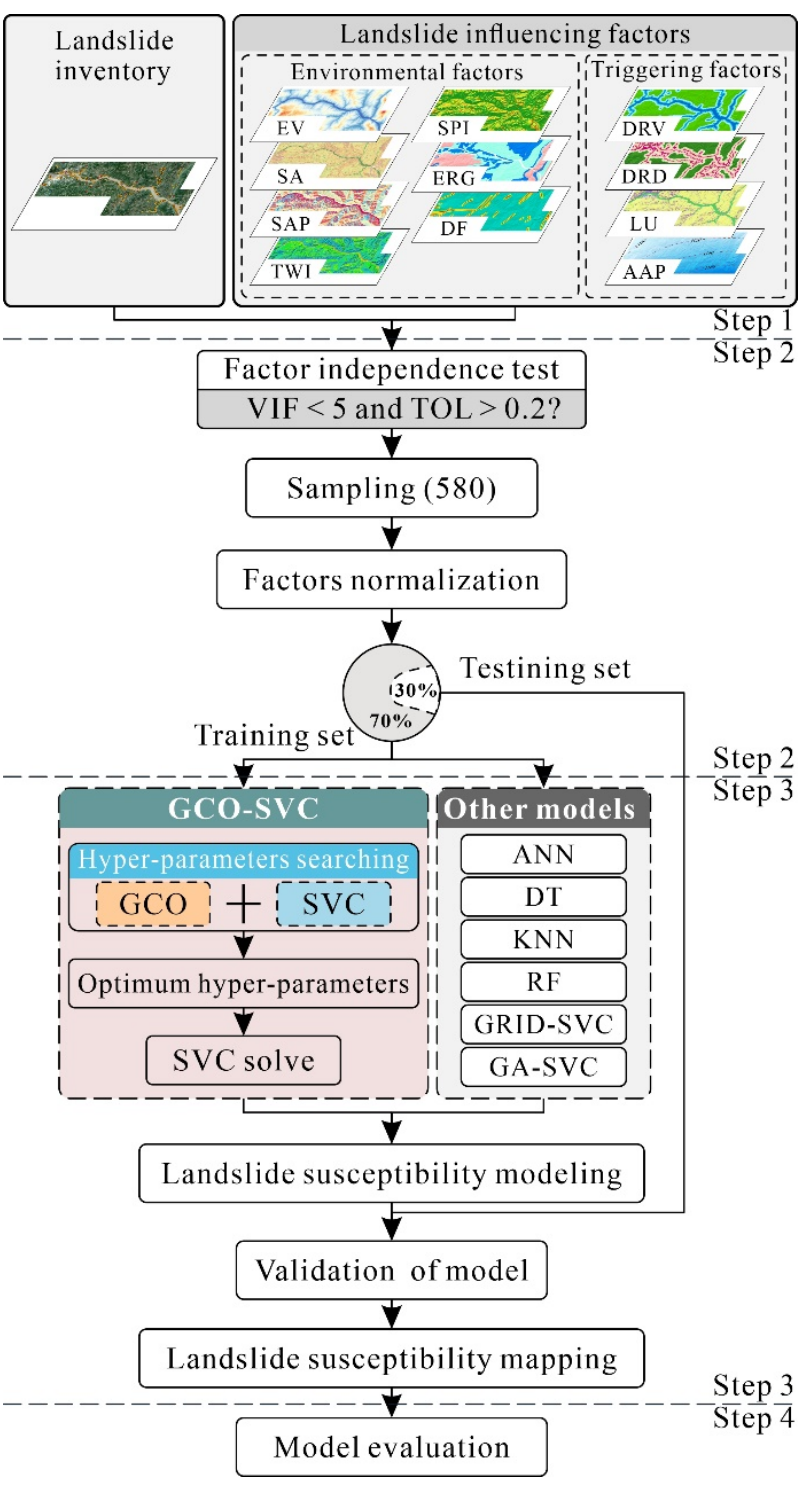
Figure 1. Flowchart. Figure 1.